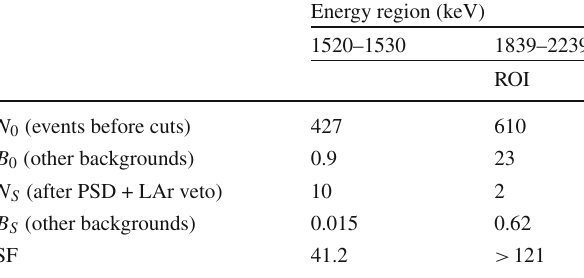
Table3 Numberofcountsfromthe 42 Kmeasurementsandsuppression factors in two energy regions, before and after applying different cuts for the BEGe detector without the